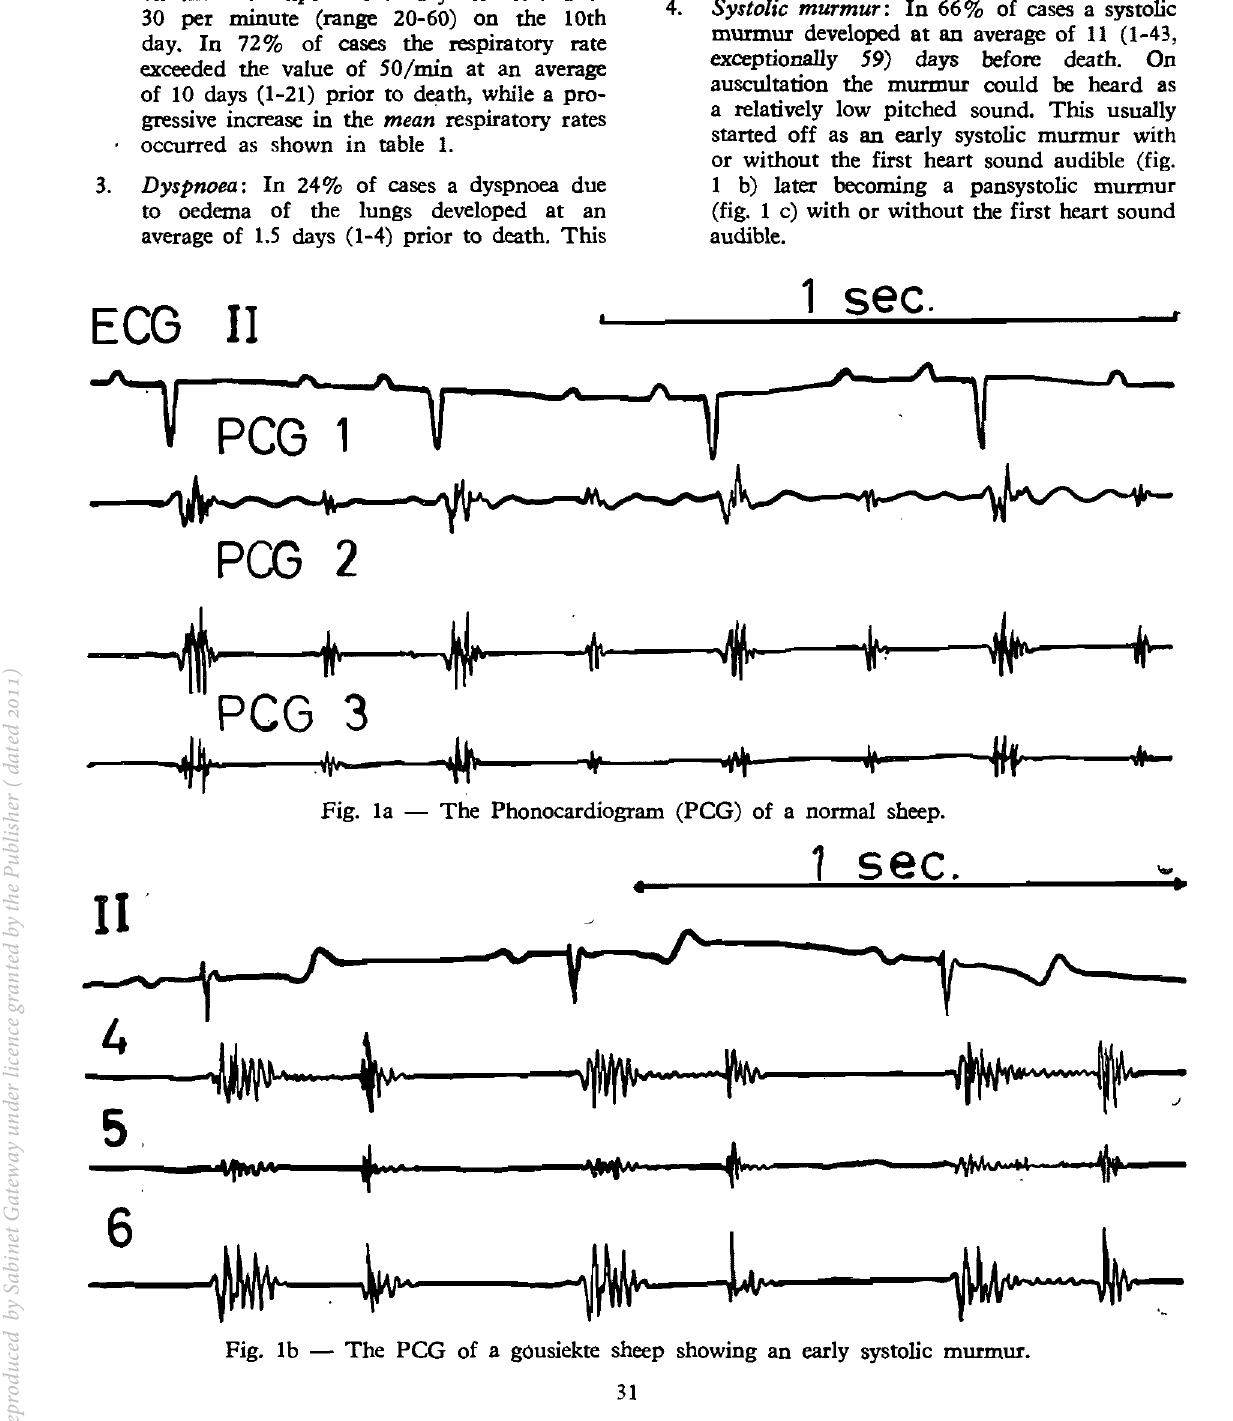
Fig. 1b - The PCG of a gousiekte sheep showing an early systolic murmur.